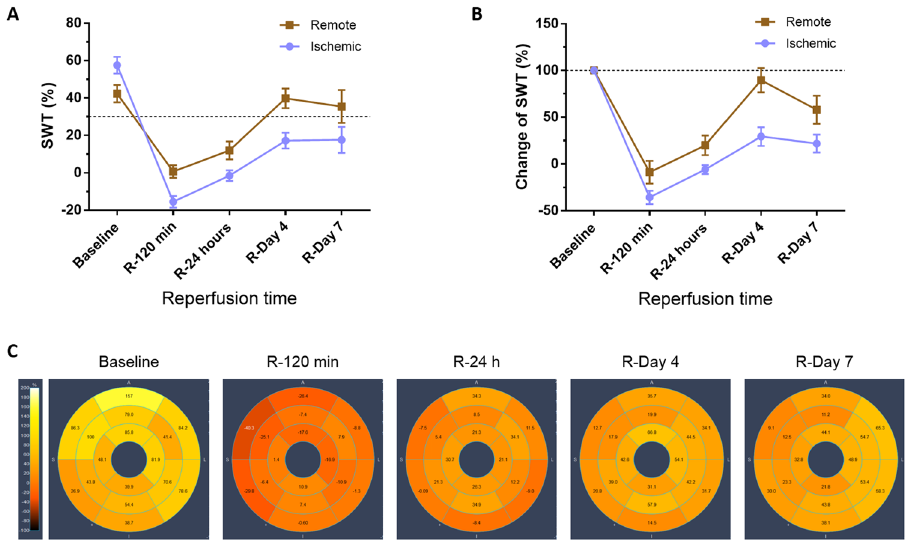
Figure 2. Functional cardiac magnetic resonance during early post-I/R remodeling. Time course of regional contractility in the ischemic and remote myocardium. Systolic wall thickening (SWT) in the ischemic and remote myocardium: ( A ) Absolute values. ( B ) Percentage SWT change relative to baseline. Symbols and bars denote mean and standard error of the mean. Dashed lines indicate reference values from healthy pigs, before induction of myocardial infarction. Myocardial segments were considered dysfunctional if SWT is 30% or less. ( C ) Representative bullseye display of SWT in one pig at baseline and over the first week post I/R after 40-minute mid left anterior descending coronary artery occlusion. Transient contractile dysfunction was observed in the remote myocardium at early post-I/R Proteome changes in the remote myocardium during early stage remodeling after I/R. At early post-reperfusion stages (120 min to 24 h) the remote myocardium showed a transient coordinated upregulation of proteins related to ATPase activity, muscle thin filament (mainly troponins, tropomyosins, and tropomodulin), proteolysis, fibrillar collagen deposition, and mitochondrial ribosomes (Fig. 5a). Conversely, there was a tran- sient downregulation of muscle thick filament proteins, accessory contractile proteins, and proteins related to several mitochondrial processes (including carriers, tricarboxylic acid cycle, fatty acid beta-oxidation, and ETC complexes, mainly affecting complexes III and IV) (Figs 5b, S3 and S4). With the exception of fibrillar collagen,